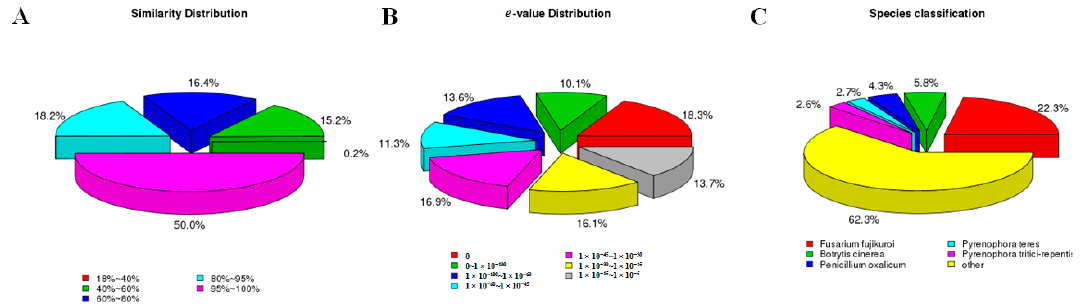
Figure 3. Species distribution of F. Proliferatum unigenes. ( A ) Similarity distribution of top Basic Local Alignment Search Tool (BLAST) hits for each unigene; ( B ) e -value distribution of BLAST hits with a cut off e -value of 1 × 10 − 5 ; ( C ) Species distribution for top BLAST hits in the Nr database.